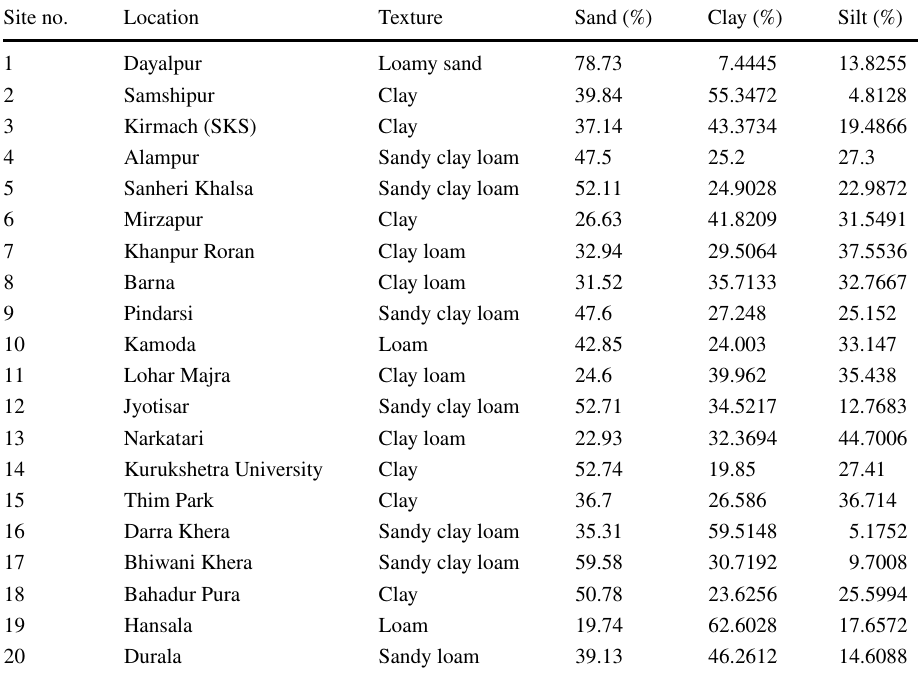
Table 1 Texture of the soil